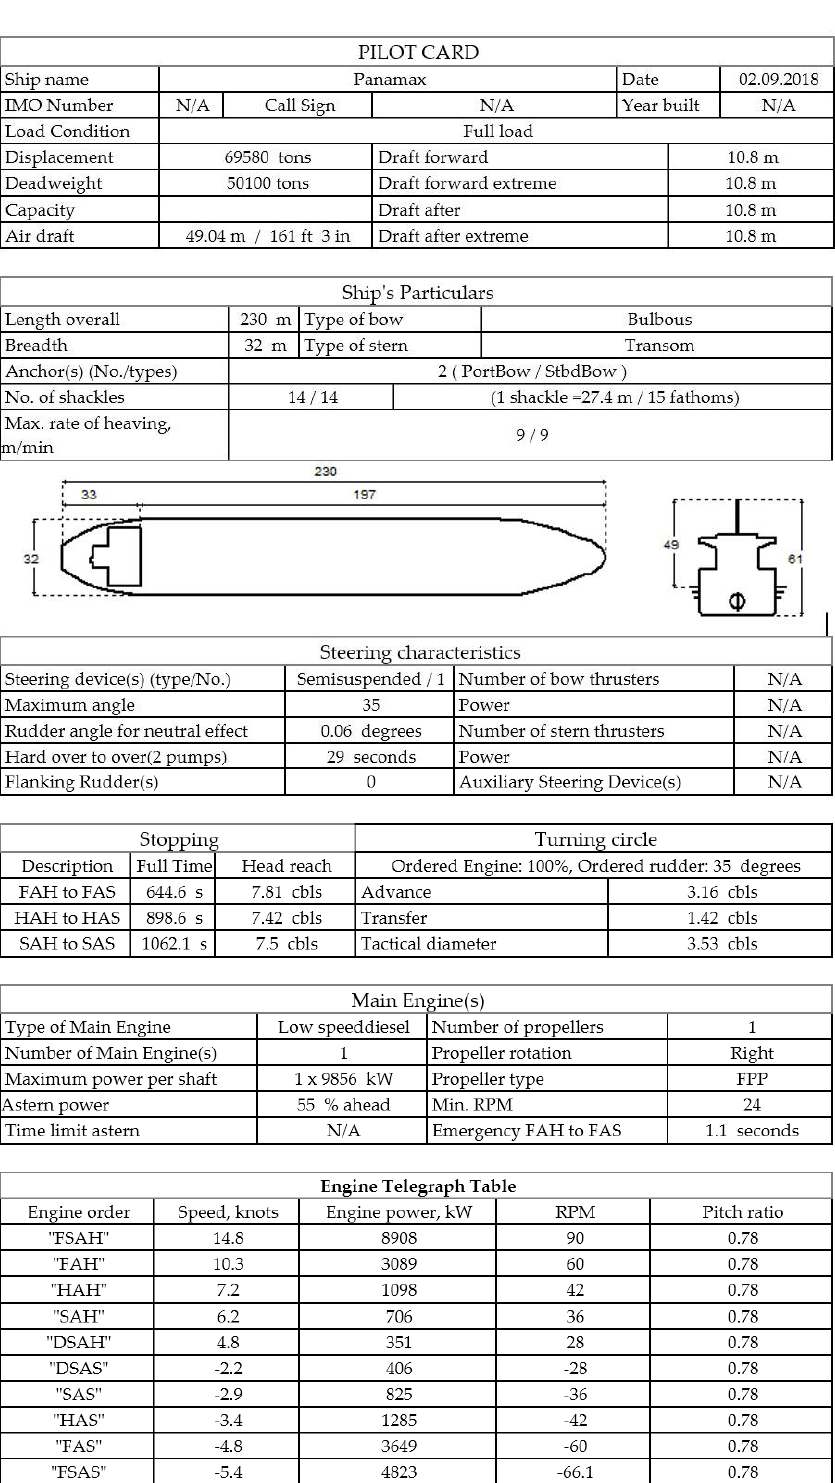
Figure 15. Pilot card of the vessel used during the research. The simulation tests included towing a ship in the Kashubian Canal. Several simula- tion tests were carried out for various weather conditions. The tests were conducted for